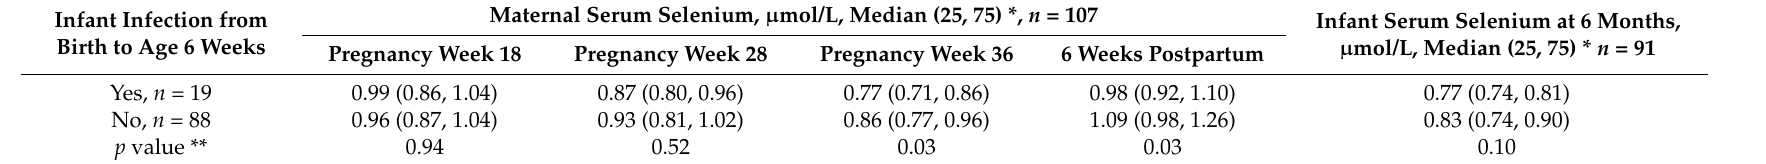
Table 6. Maternal and infant serum selenium in relation to reported infant infection from birth to age 6 weeks. Infant Infection from Birth to Age 6